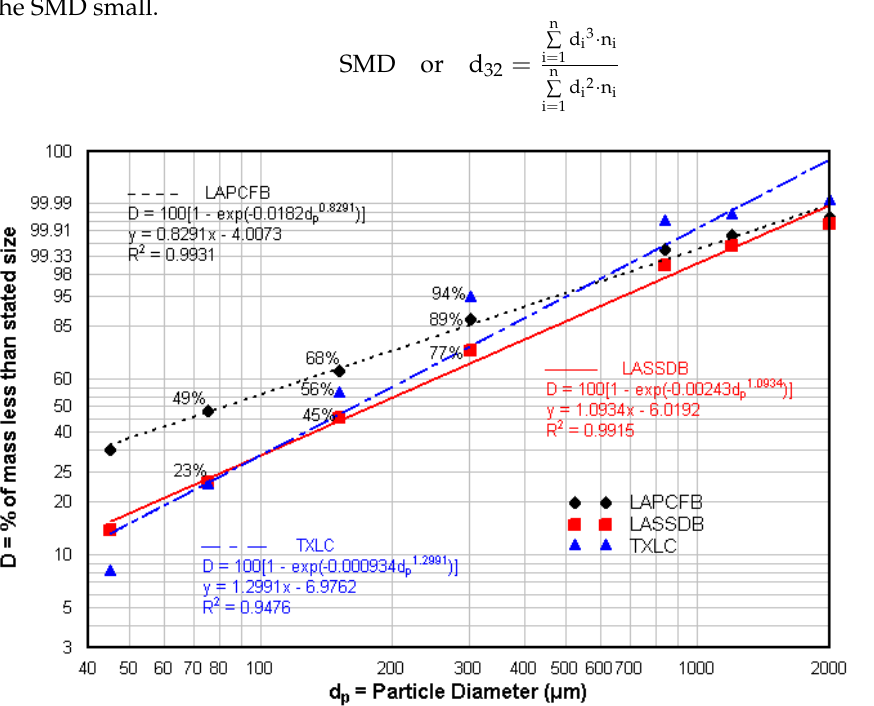
Figure 4. Particle size (Rosin-Rammler) distributions of the reburn fuels. Cumulative Mass %, D = 100 {1 − exp( − bd pn )}, see Chapter 4 of Ref. [36], y = ln { − ln{1 − (D/100)}, x = ln(d p ), y = nx + A, A = ln(b). Data fit for TXLC yields A = − 6.9762, n = 1.2991. Similar procedure for LAPCFB and LASSDB. Table 6. Fuel particle size distributions. Mean Dia. ( µ